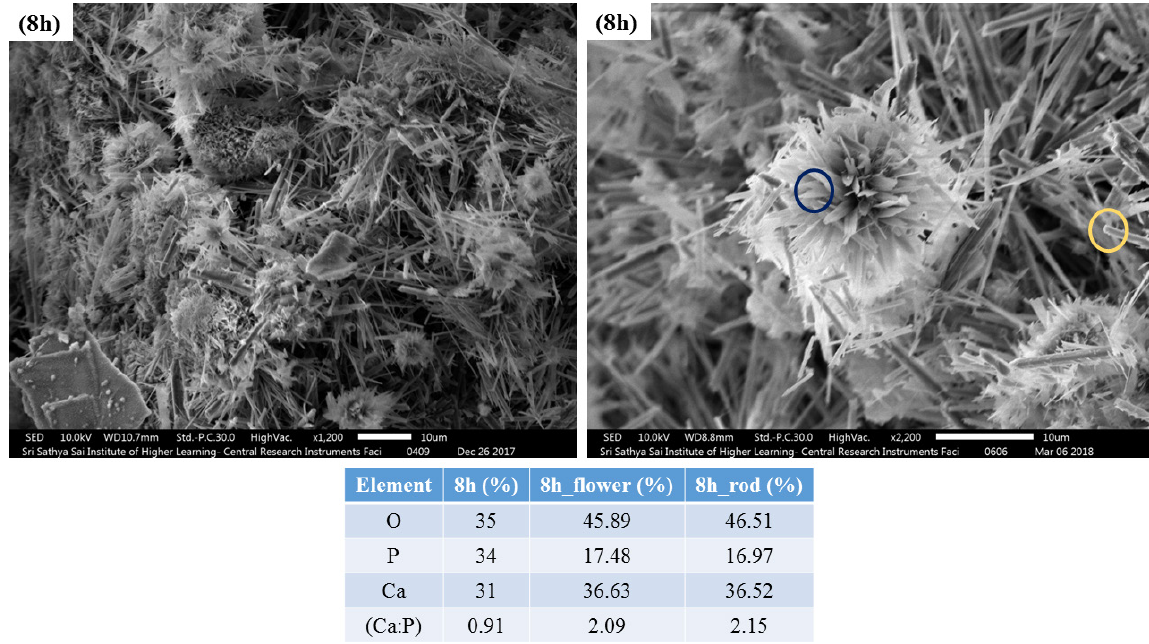
Figure S4: SEM images and corresponding EDX report of the composition of the nano-hydroxyapatite in the rod and flower composition at 8h dwell time of hydrothermal synthesis at 10 µ m